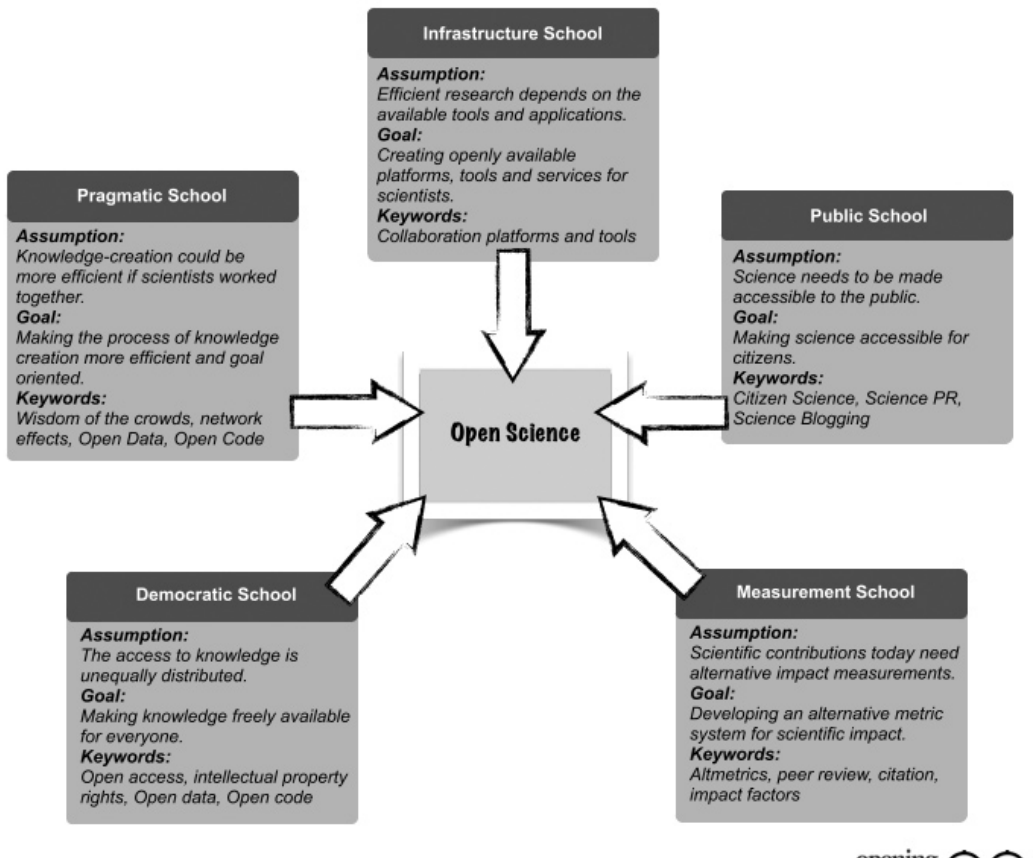
Figure 8. Five schools of thought in Open Science (CC BY-NC, Fecher & Friesike,